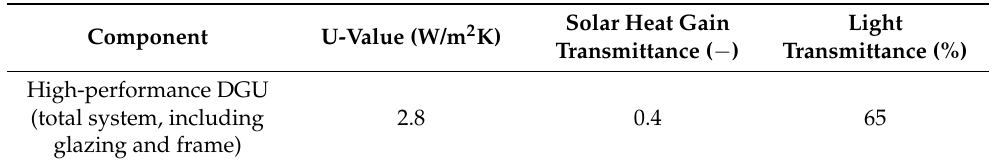
Table 2. Thermal and visual performance of the transparent elements of the envelope. Modelled based on standard values reported by the NCC